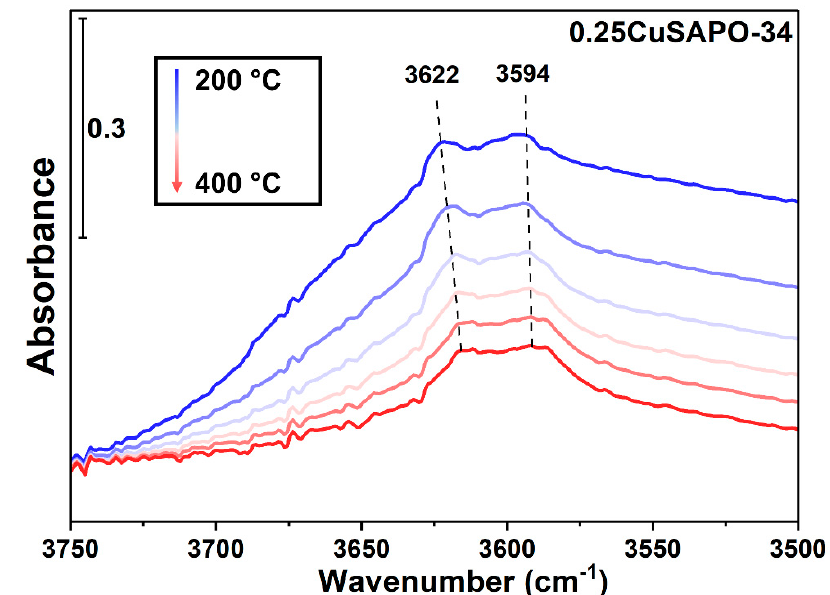
Figure 6. Spectra of O 2 -activated 0.25CuSAPO-34. The temperature increases gradually from 200 ◦ C (blue) to 400 ◦ C (red). The dashed lines represent two peaks related to the Brønsted acid sites of the material. No band is observed at 3650 cm − 1 (fingerprint region of Z[Cu(II)OH] vibrations).